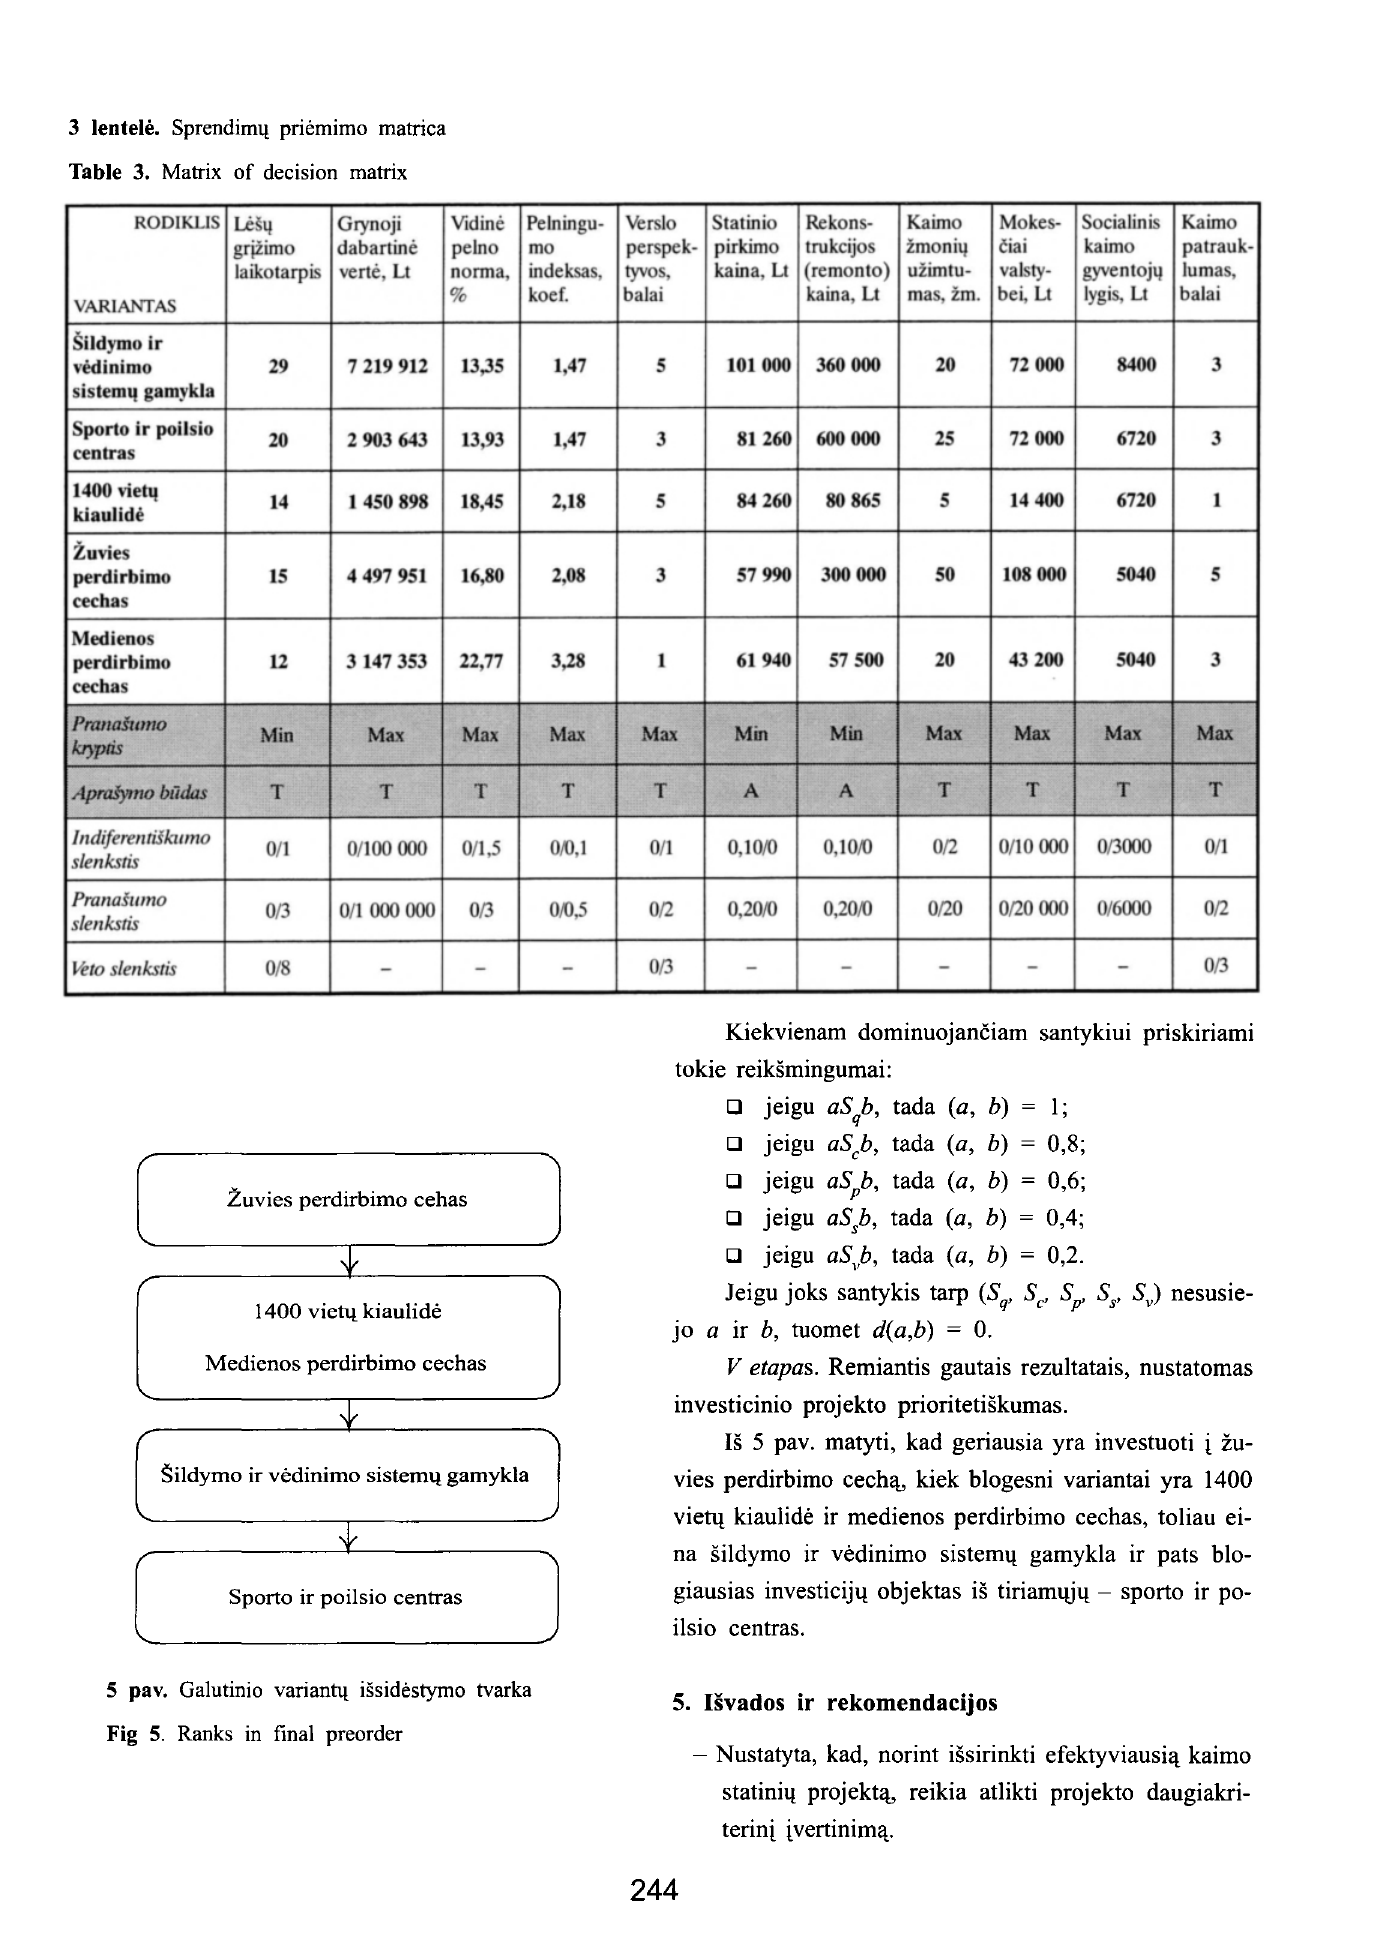
Table 3. Matrix of decision matrix